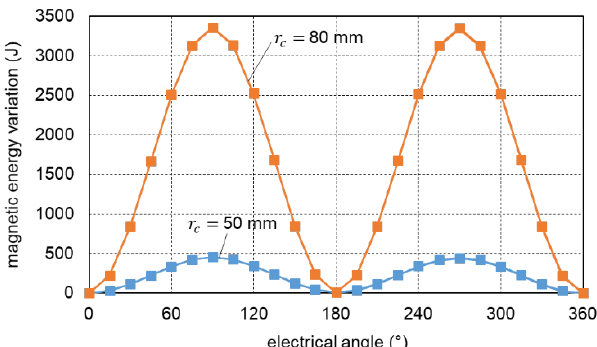
Figure 4. Magnetic energy variation ∆ W during a full rotation of the RPMCs evaluated by the energy balance and direct FEAs (squared dots).